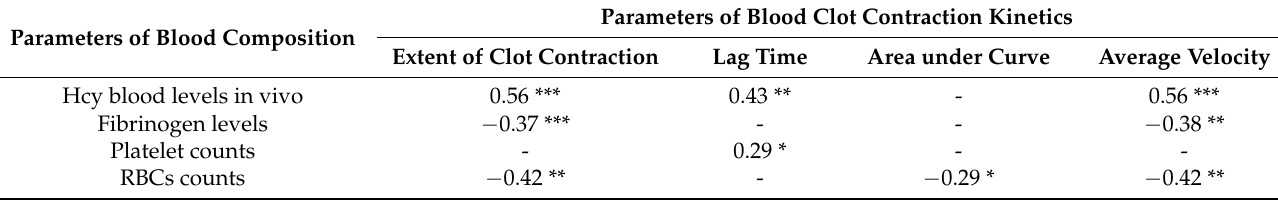
Table 4. Correlation analysis between the parameters of in vitro clot contraction and blood composition in the HHcy rats. Parameters of Blood